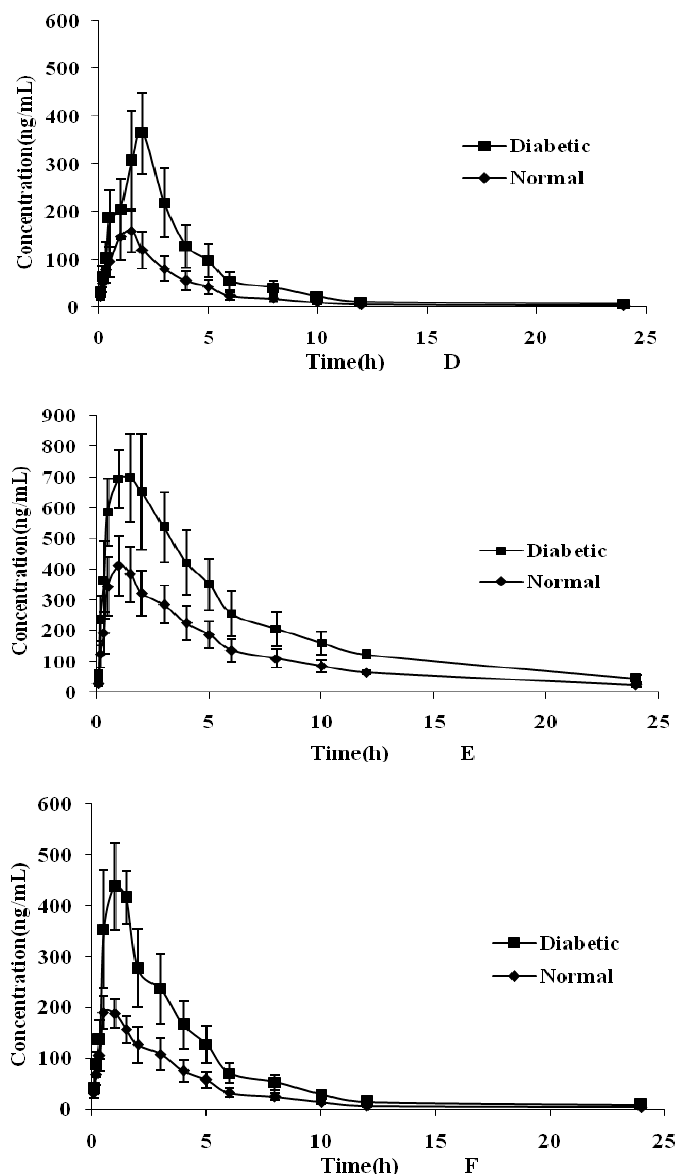
Figure 3. Plasma concentration-time curves for cynaroside ( A ), quercetin ( B ), luteolin ( C ), isorhamnetin ( D ), rutin ( E ), formononetin ( F ) in rat plasma after oral administration of Maydis stigma decoction at 5.0 g·kg − 1 to rats in normal and diabetic groups. Each point represents the mean ± S.D. ( n = 6).